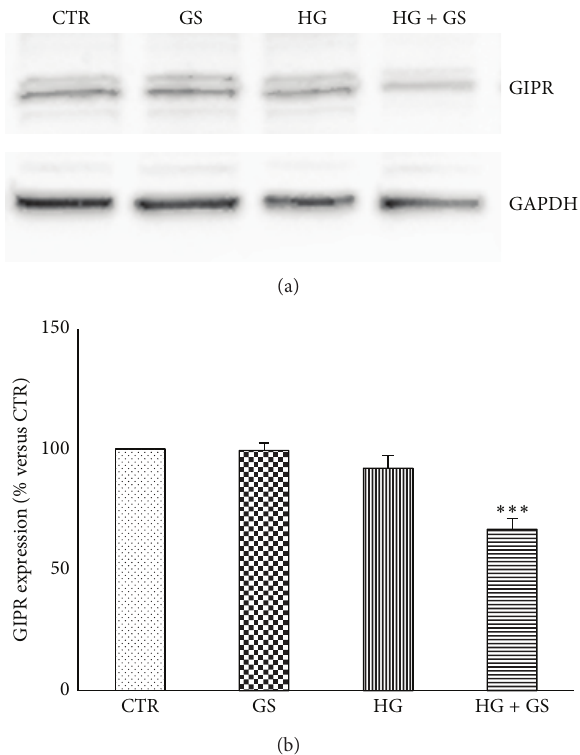
Figure 1: Treatment with GS reduces GIPR protein expression in cells cultured under HG. HIT-T15 cells were cultured for 5 days in media containing 5.6 mmol/L (CTR) or 11.1mmol/L glucose (HG) supplemented with GS. Then cells were lysed and tested for protein expression of GIPR. (a) Representative western blot analysis. (b) Quantification of densitometries of western blot bands. Data were expressedasmean ± SEoffoldinductionrelativetoGAPDH( 𝑛 = 3 ). ∗∗∗ 𝑃 < 0.001 versus CTR.